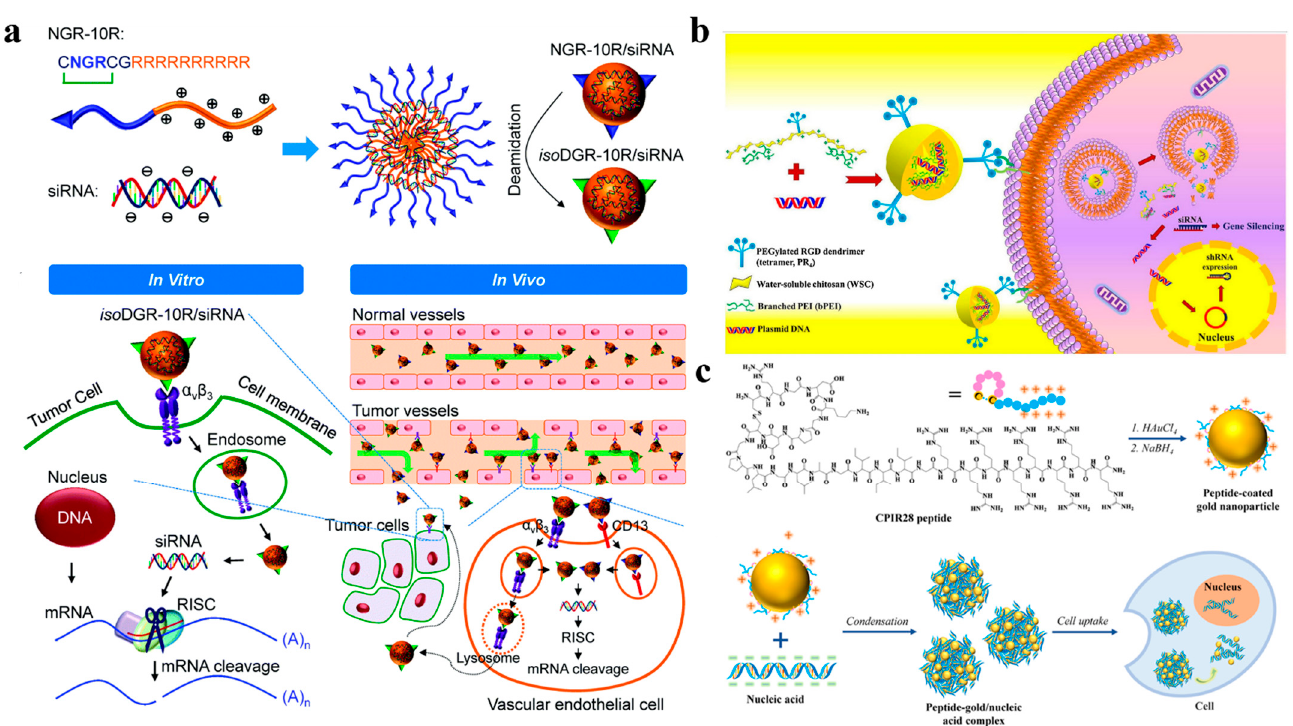
Figure 4. ( a ) Bi-functional NGR-10R peptide condenses siRNA to form spherical nanostructures which can enter cells by receptor α v β 3 and CD13 mediated endocytosis. After escaping from the